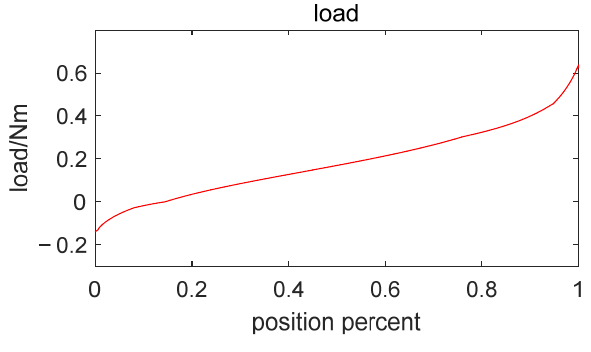
Figure 3. Load Figure 3. Load curve.